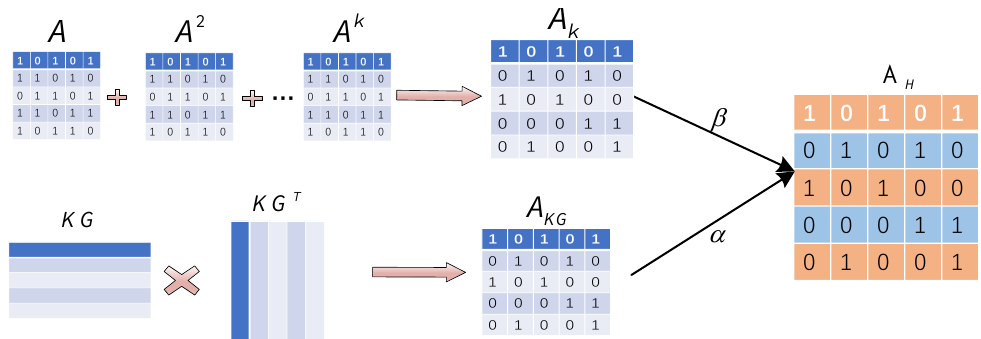
Figure 2. Homogeneous adjacency matrix